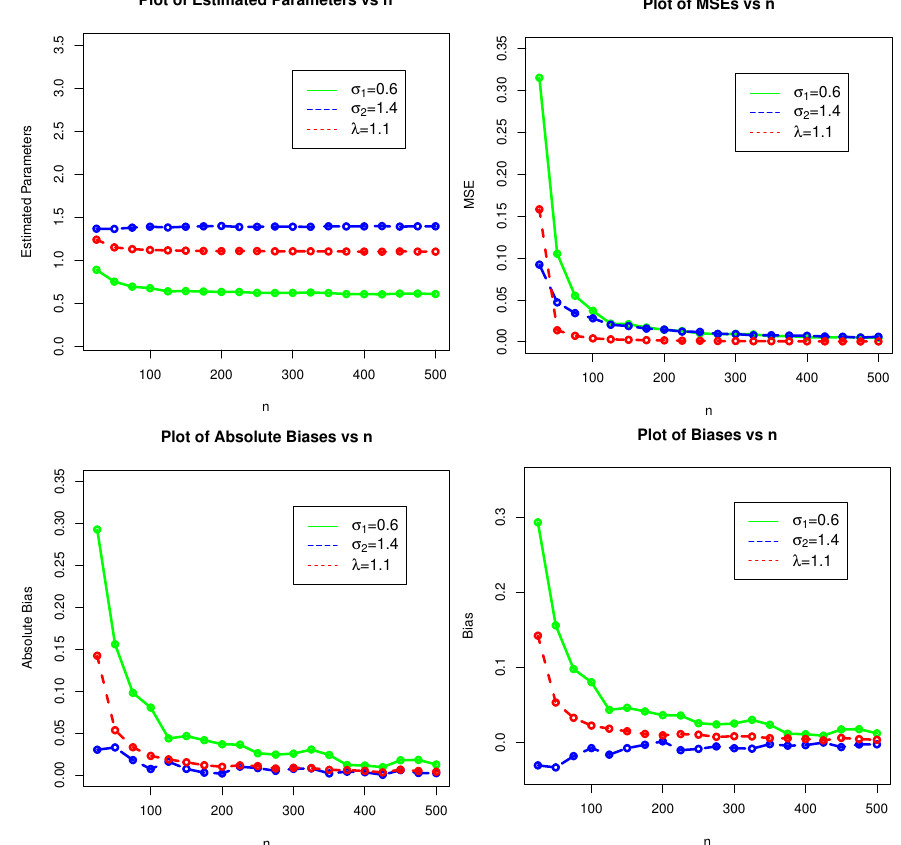
Figure 2. A visual display of the results of the SimS of the NMFWE model for σ 1 = 0.6, σ 2 = 1.4, and λ =